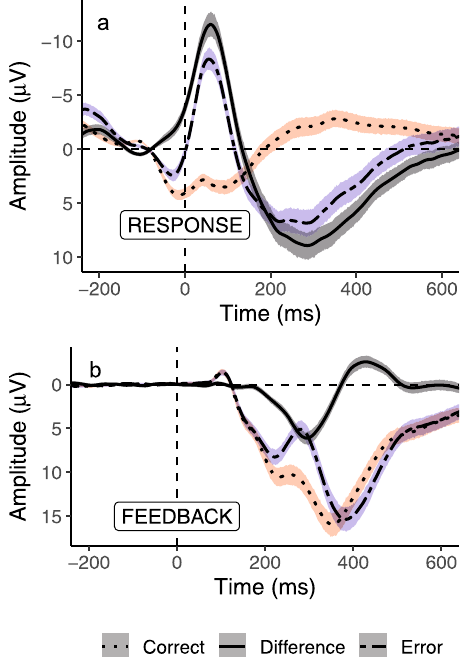
Fig. 2 The ERN and RewP at electrode FCz. a , b Central lines depict the grand average ERP amplitude across participants (dotted line: correct; dash-dotted line: error; solid line: difference wave, and the shaded error bands denote 95% between-subjects con fi dence intervals (red: correct; blue: error; black: difference wave). Timepoint zero in the ERN waveform refers to the participants button-press response, whereas timepoint zero in the RewP waveform refers to the onset of the external feedback stimulus. The ERN was signi fi cantly more negative on error than correct trials, two- sided paired samples Student ’ s t test: t (169) = 20.42, p < 0.001, d = 1.57, 95% CIs [1.34, 1.79], and the RewP was signi fi cantly more positive to correct feedback than error feedback on correct trials, two-sided paired samples Student ’ s t -test: t (188) = 16.73, p < 0.001, d = 1.22, 95% CIs [1.03,